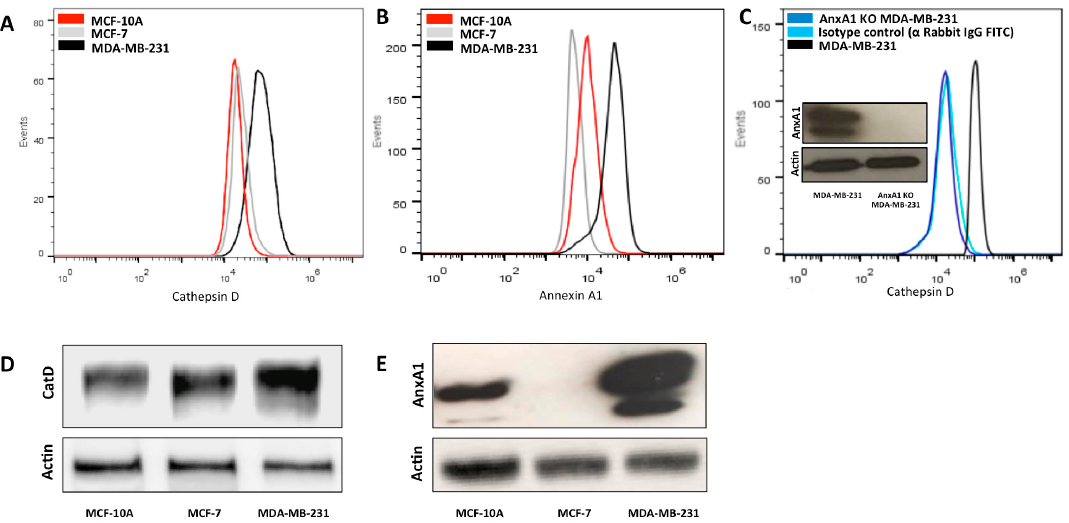
Figure 1. Enhanced expression of CatD in MDA-MB-231 cells is associated with AnxA1 expression. ( A ) Flow cytometry analysis of CatD overall protein expression in MCF-10A (red peak), MCF-7 (grey peak), and MDA-MB-231 (black peak) cells. ( B ) Flow cytometry analysis of AnxA1 overall protein expression in MCF-10A (red peak), MCF-7 (grey peak), and MDA-MB-231 (black peak) cells. ( C ) Flow cytometry analysis of CatD expression in MDA-MB-231 cells having native levels of AnxA1 (black peak), AnxA1 knockdown MDA-MB-231 (dark blue peak) cells in which AnxA1 expression was suppressed, and isotype control anti-Rabbit, IgG FITC (light blue peak). Western blotting analysis of AnxA1 expression of MDA-MB-231 cells having native levels and having complete knockdown of AnxA1 expression. ( D ) Western blotting analysis of CatD expression of MCF-10A, MCF-7, and MDA-MB-231 cells. Actin was used as loading control. ( E ) Western blot analysis of AnxA1 expression of MCF-10A, MCF-7, and MDA-MB-231 cells. Actin was used as loading control.